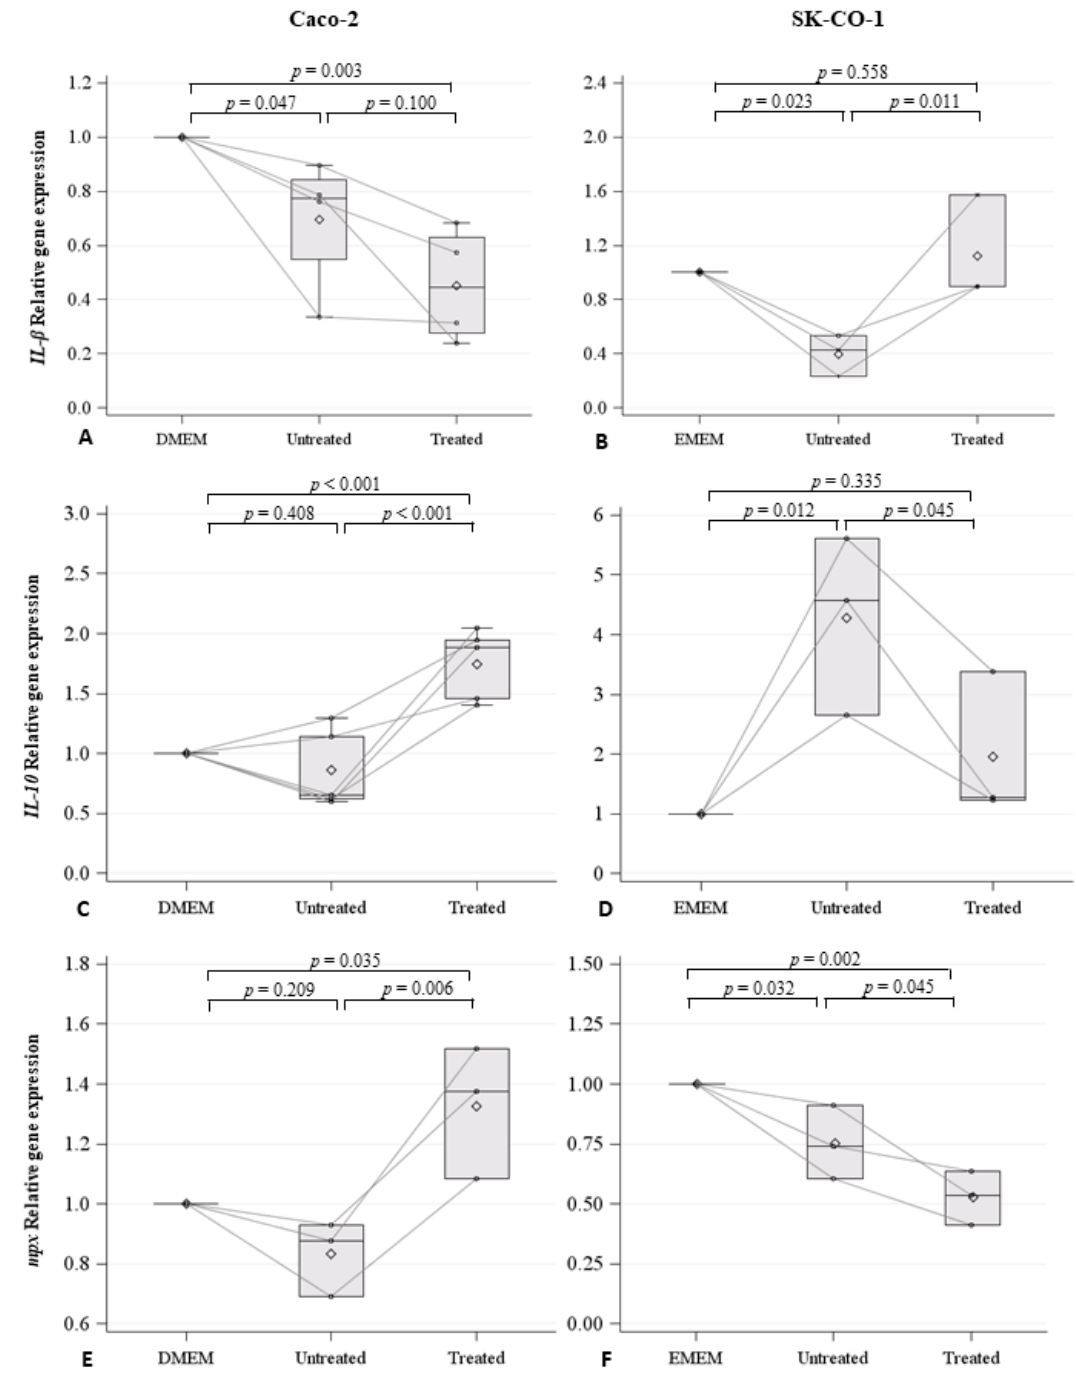
Figure 5. Spaghetti plot and box plot of IL1- β ( A , B ), IL-10 ( C , D ), and mpx ( E , F ) expression levels (RQ) in zebrafish embryos injected with control medium (i.e., Dulbecco’s Modified Eagle’s Medium (DMEM) and Eagle’s Minimum Essential Medium (EMEM), respectively), with EVs derived from untreated Caco-2, decitabine treated Caco-2 cells, untreated SK-CO-1, and decitabine-treated SK-CO- 1 cells.